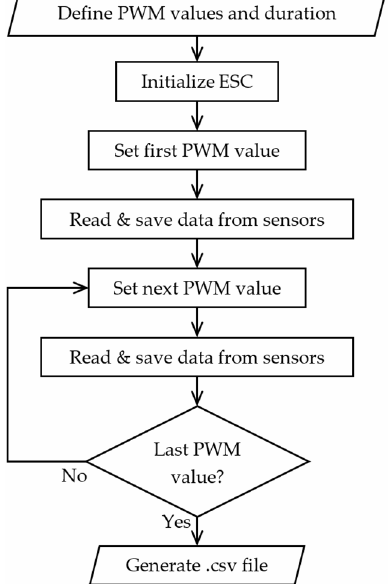
Figure 5. Setup script flowchart.